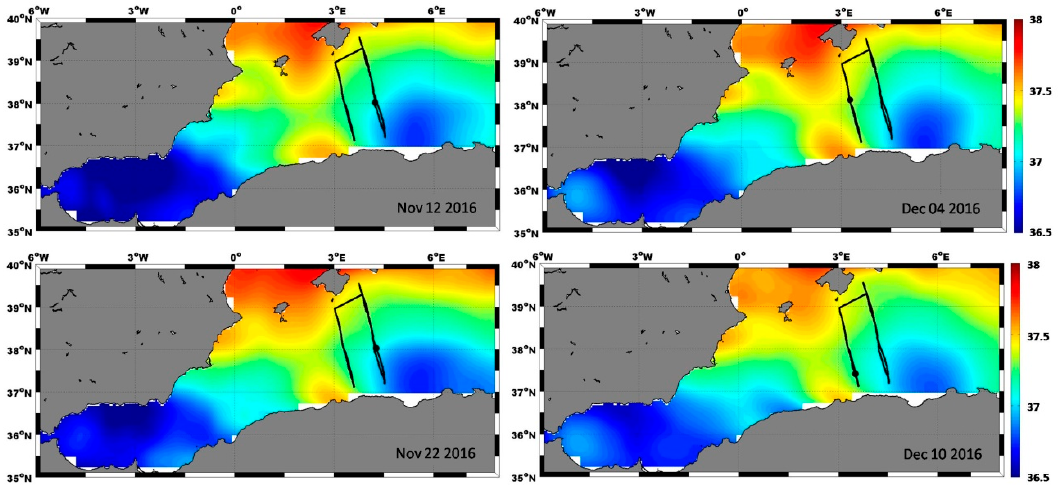
Figure 16. SMOS L4 SSS maps of the Alboran Sea and the Algerian Basin on four representative dates of the ABACUS 3 survey. Glider track in black.